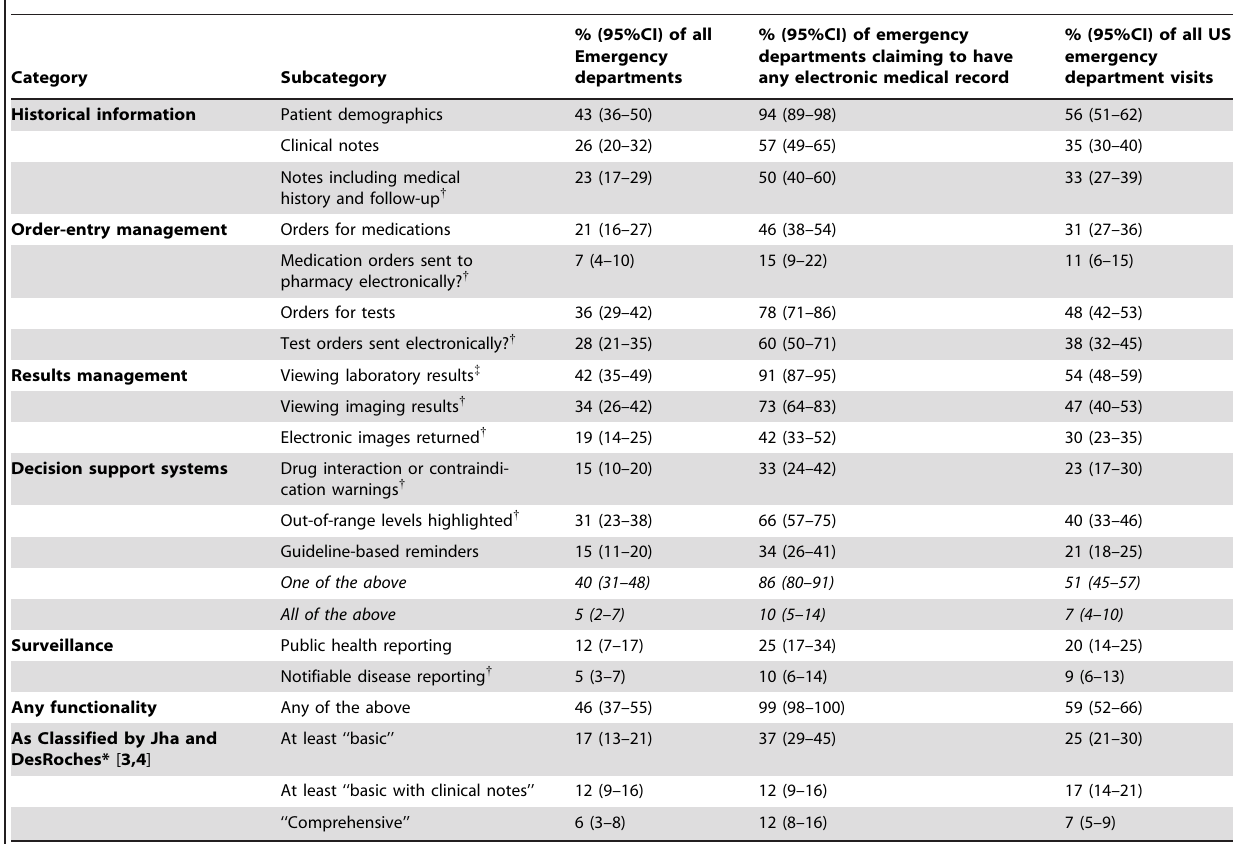
Table 1. Adoption of Individual Electronic Medical Record Functionalities by US Emergency Departments by 2005–2006.